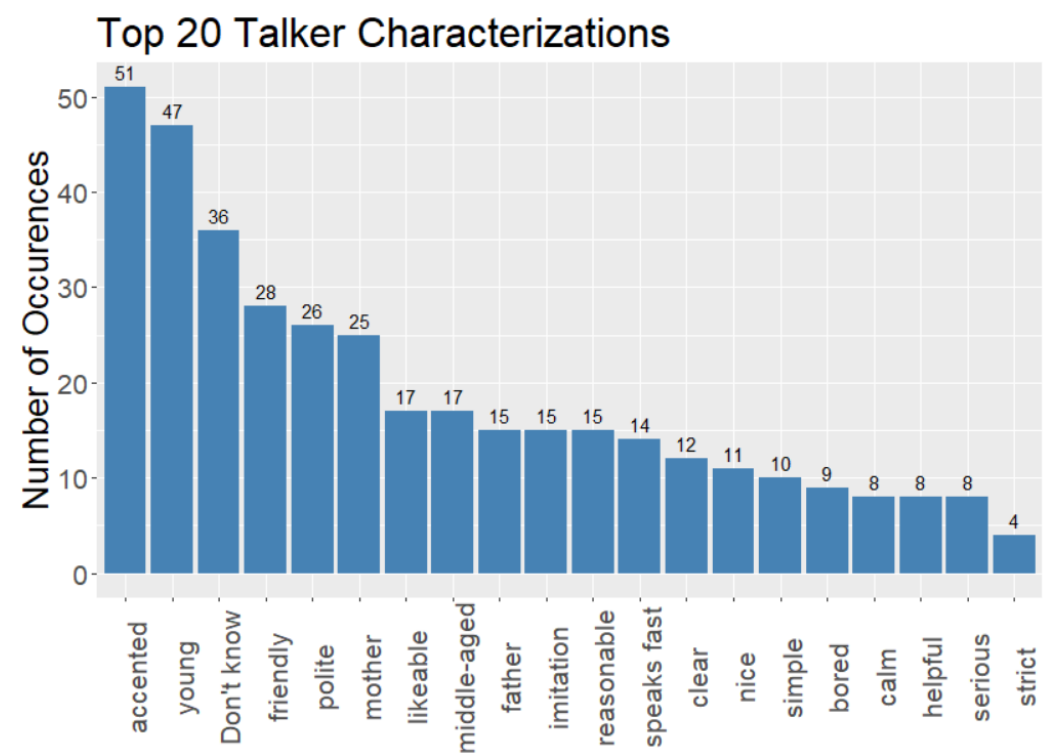
Figure 2. Top 20 talker characterizations by Albanian and Greek subjects with the number of occur- rences in the data. 4 occurrences in the data.